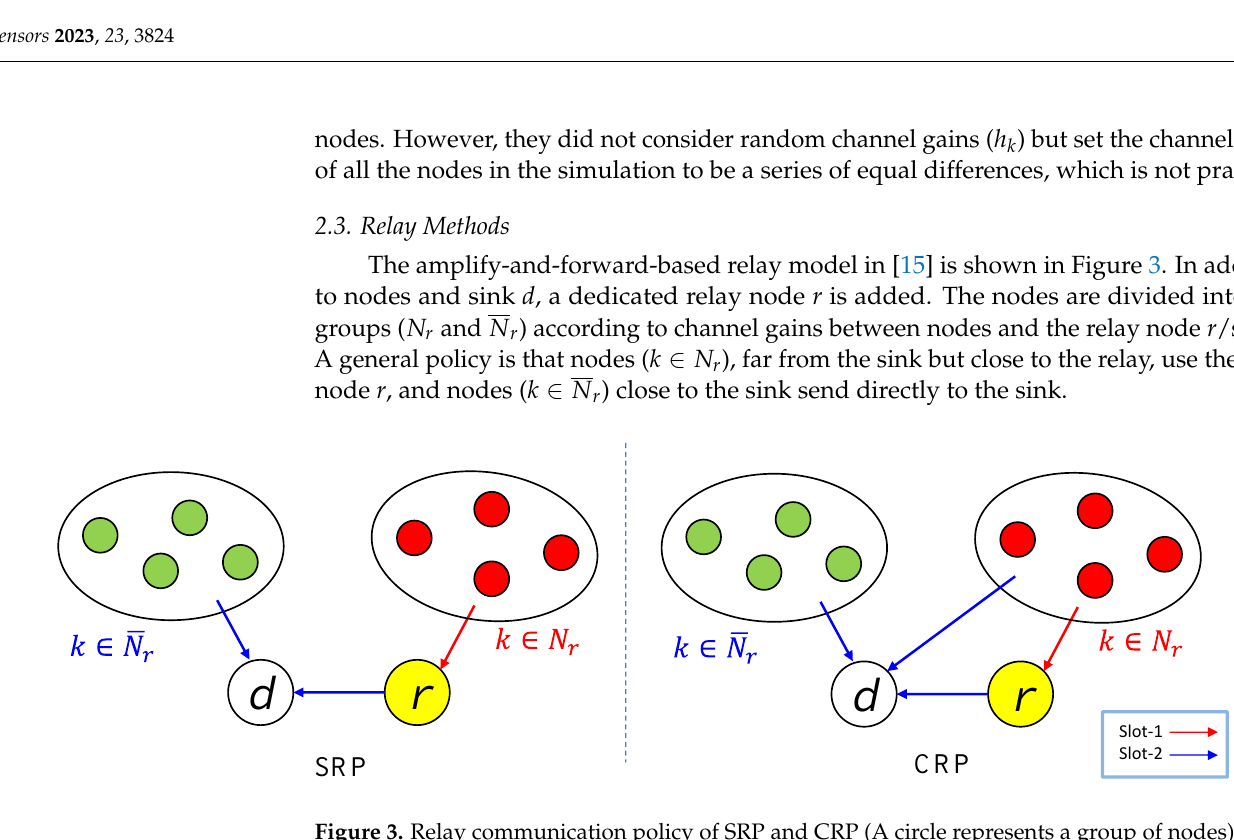
Figure 3. Relay communication policy of SRP and CRP (A circle represents a group of nodes).